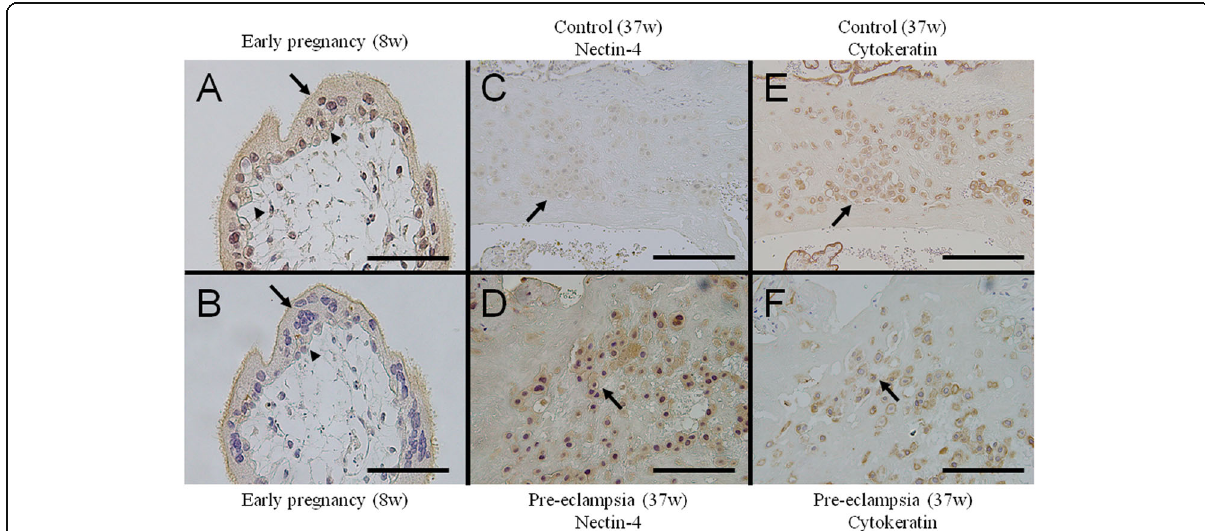
Fig. 4 Nectin-4 immunostaining of tissue sections. Chorionic villi from early gestation was stained with polyclonal goat ( a ) or rabbit ( b ) antibodies against human nectin-4. Signals are observed in the syncytiotrophoblast (arrow) and cytotrophoblast cells (arrowhead). Maternal decidua was also examined using goat polyclonal antibodies against human nectin-4 ( c and d ). A subset of cells, possibly extravillous trophoblasts, is positive for nectin-4 staining (arrows). To detect cells of the trophoblast lineage, anti-pancytokeratin monoclonal antibodies were used ( e and f ). Original magnifications a-f : 400 x. Scale bars, 100 μ